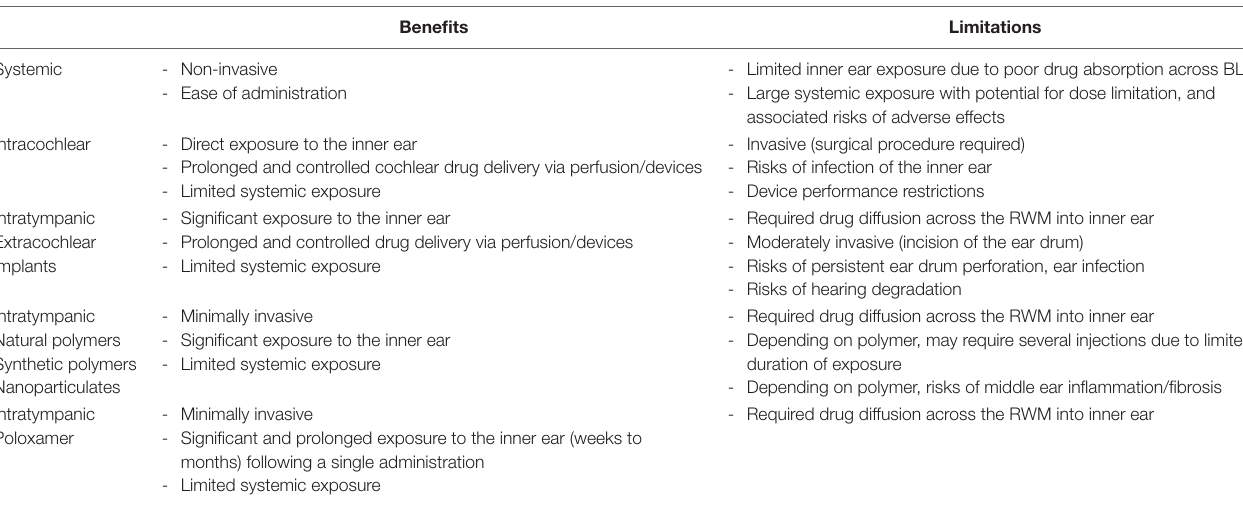
TABLE 2 | Comparison of different routes of administration to the inner